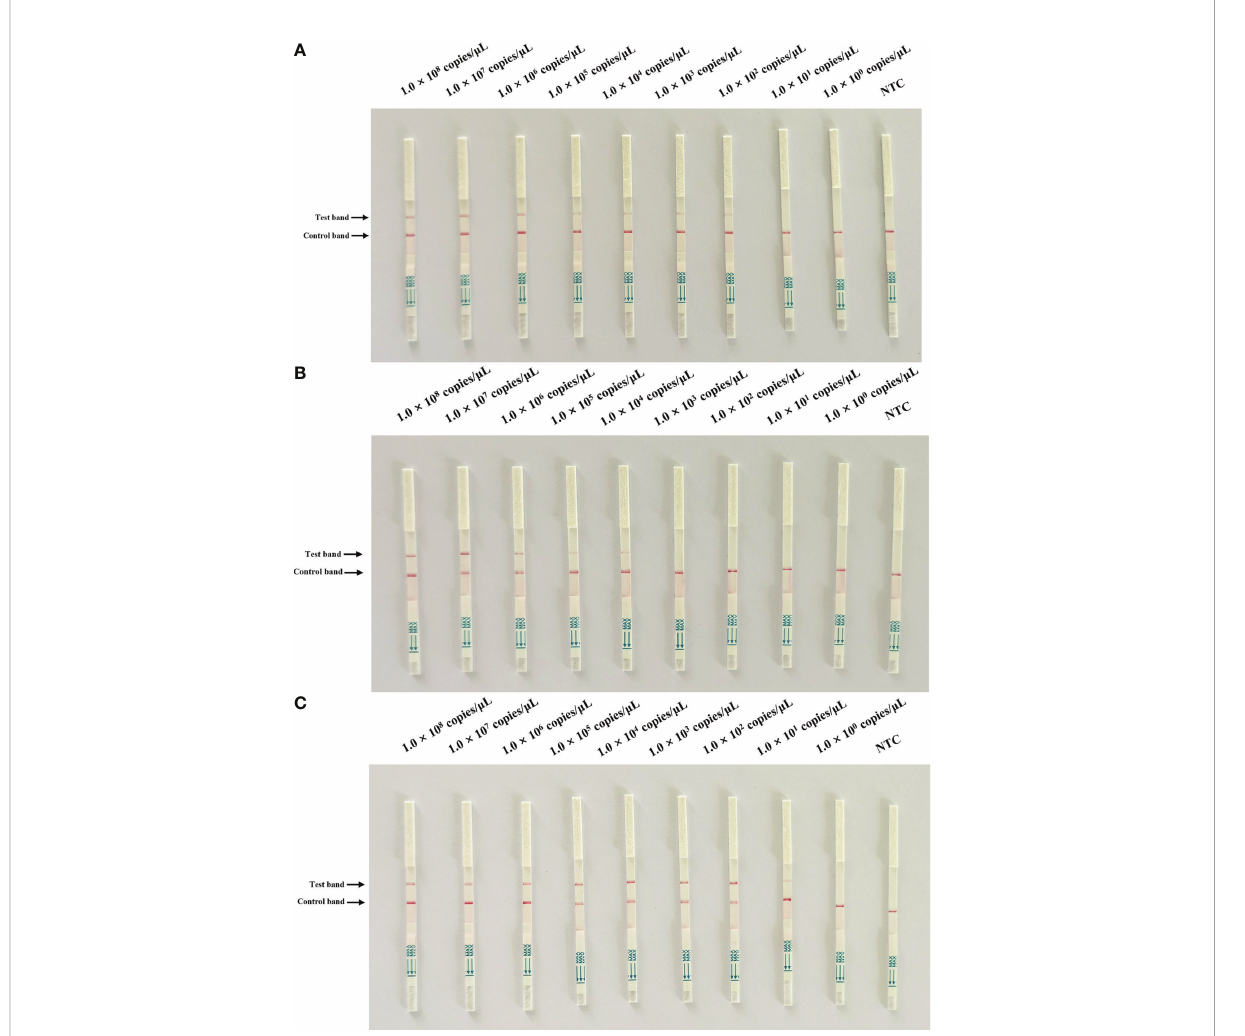
FIGURE 3 Sensitivity test of Cas13a lateral fl ow detection. A 10-fold serial dilution of pMD19T-ORF3 was used as the detection template. (A) Sensitivity test of the primer1 + crRNA1 combinations. (B) Sensitivity test of the primer2 + crRNA2 combinations. (C) Sensitivity of the primer2 + crRNA2 combination after reaction system optimization. NTC, negative